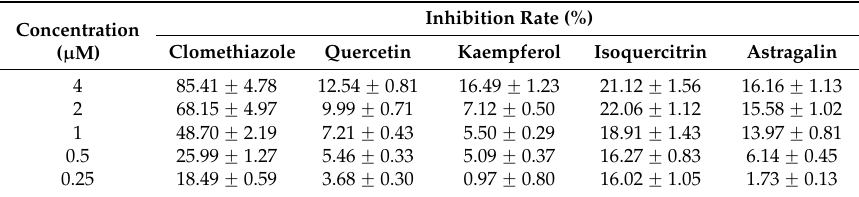
Table 4. Effects of flavonoids on CYP3A4 isozyme activities ( ⎯ x ± s, n = 3).